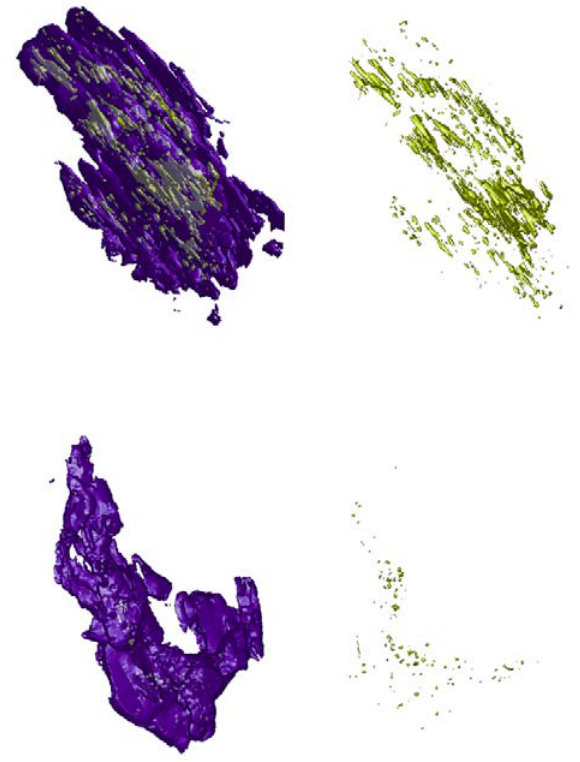
FIGURE 2 . Representations of three-dimensional reconstructions of total pancreatic tissue (left side) and islet tissue (right side) from WT (top row) and AGD (bottom row) adult mice (see text for results of quantification).